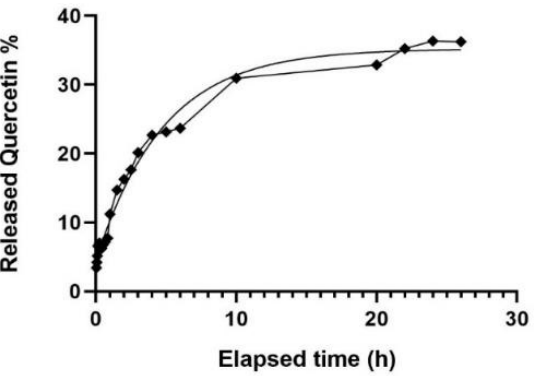
Figure 7. Quercetin release from QuercSLN in 65:35 H 2 O/EtOH dissolution medium. Table A1 reports values ± SD.